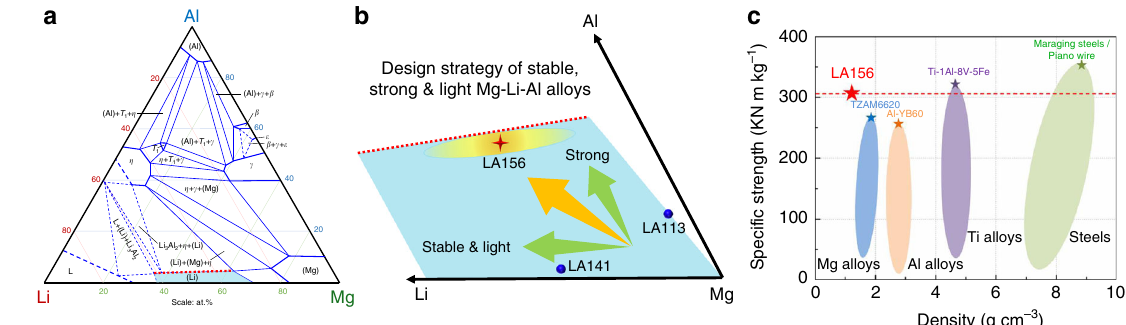
Fig. 5 Design strategy for structurally stable, ultra-high-speci fi c-strength body-centred cubic (BCC) Mg-Li-Al alloys. a Isothermal section of the Al-Li-Mg ternary system at 400 °C, adapted from SpringerMaterials. The single β -Li phase fi eld is highlighted in light blue. b Schematic illustration of single β -Li phase area shown in a . The ternary alloy becomes more stable and less dense with increasing Li addition and stronger with more Al addition within the single β -Li region at 400 °C. The red dashed line shows the solubility limit of Al, whereby AlLi will form beyond it. The elliptic area provides a compositional guide for generating structurally stable, strong and light alloys. c Speci fi c strength of LA156, compared with a large number of conventional Mg alloys, Al alloys, Ti alloys and steels. It is assumed that the yield strength of LA156 is σ y = 2.83 Vickers Pyramid Number